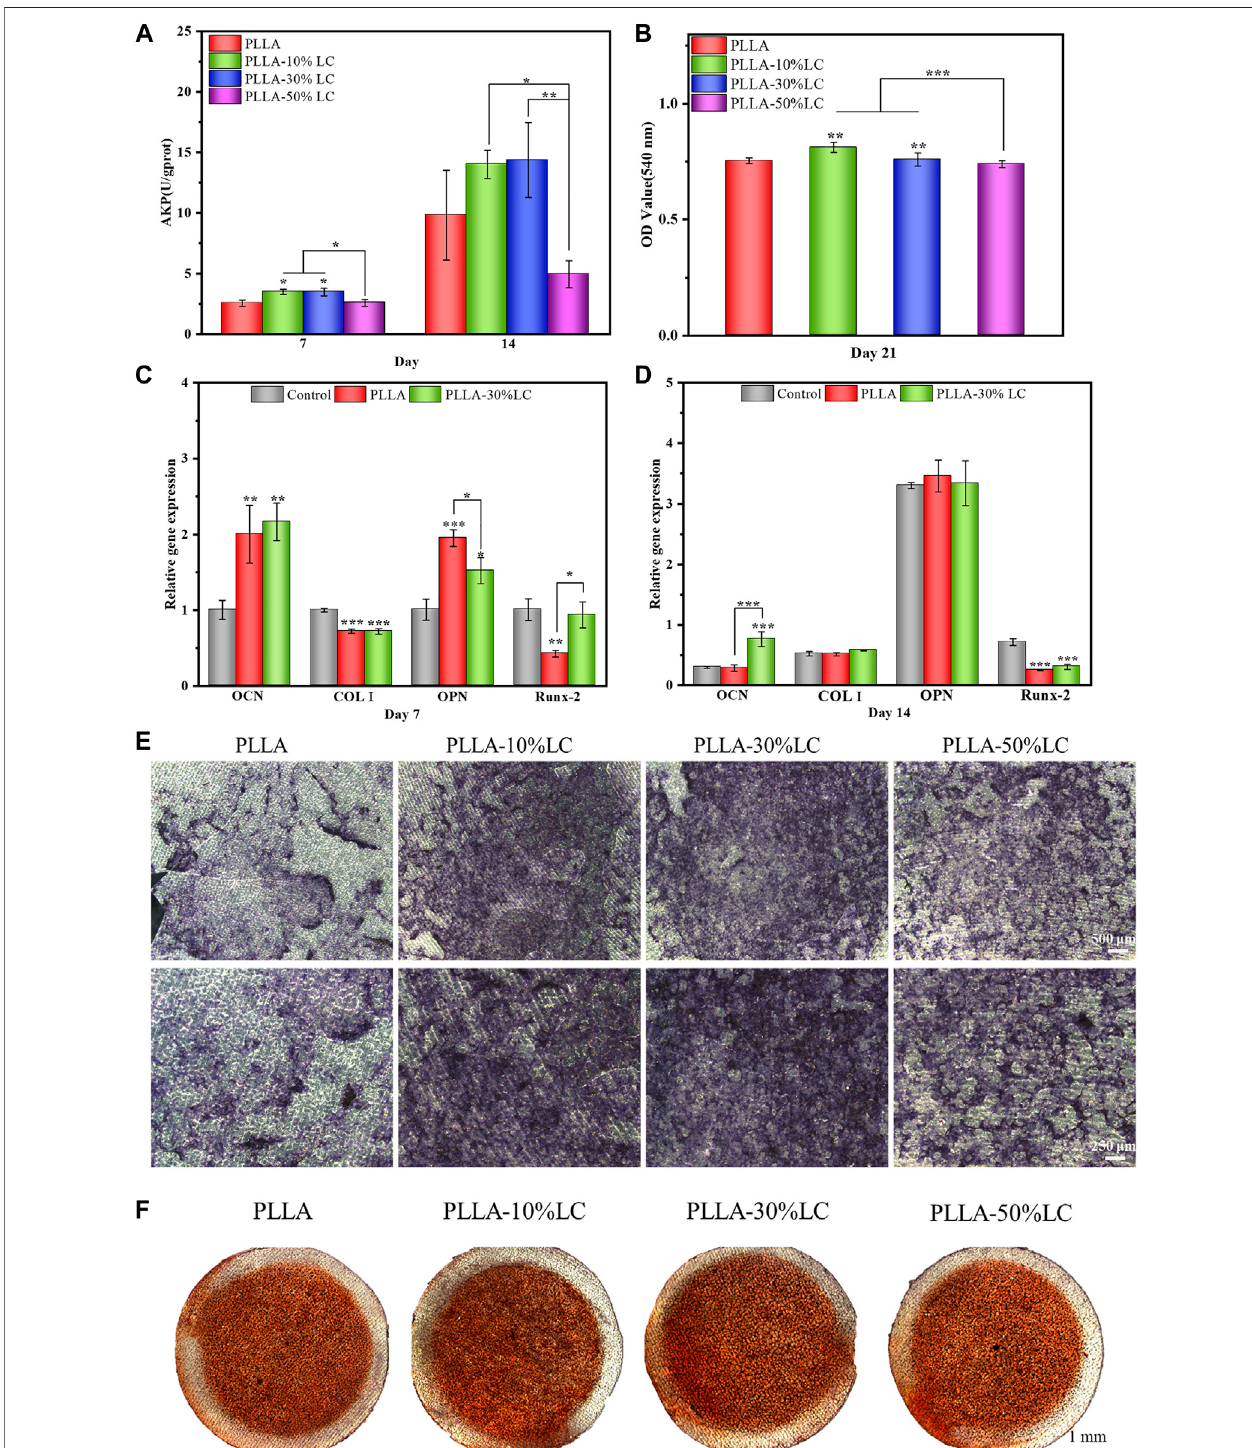
FIGURE 6 | (A) ALP quantitative analysis; (B) Alizarin Red staining quantitative analysis; (C) and (D) BMSC-related osteogenic gene expression on different materials; (E) ALP staining; and (F) Alizarin Red dyeing.